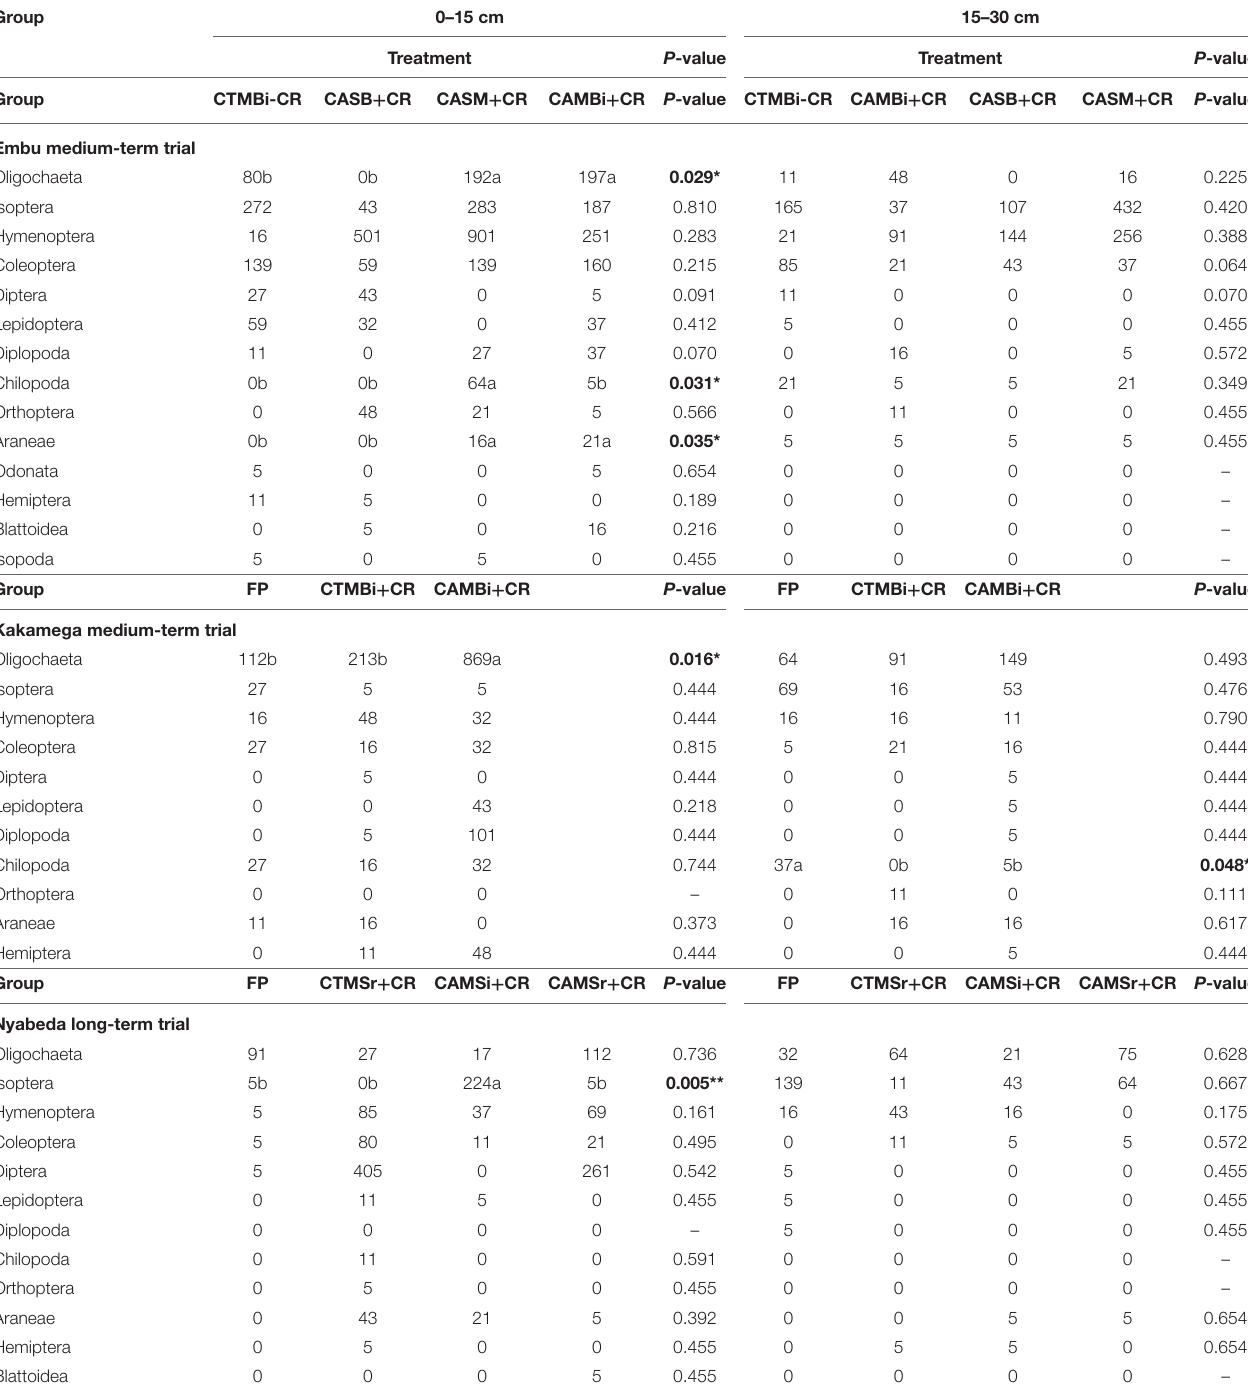
TABLE 4 | Mean abundance of soil macrofauna groups across treatments in medium-term and long term trials of Embu, Kakamega, and Nyabeda, Kenya.